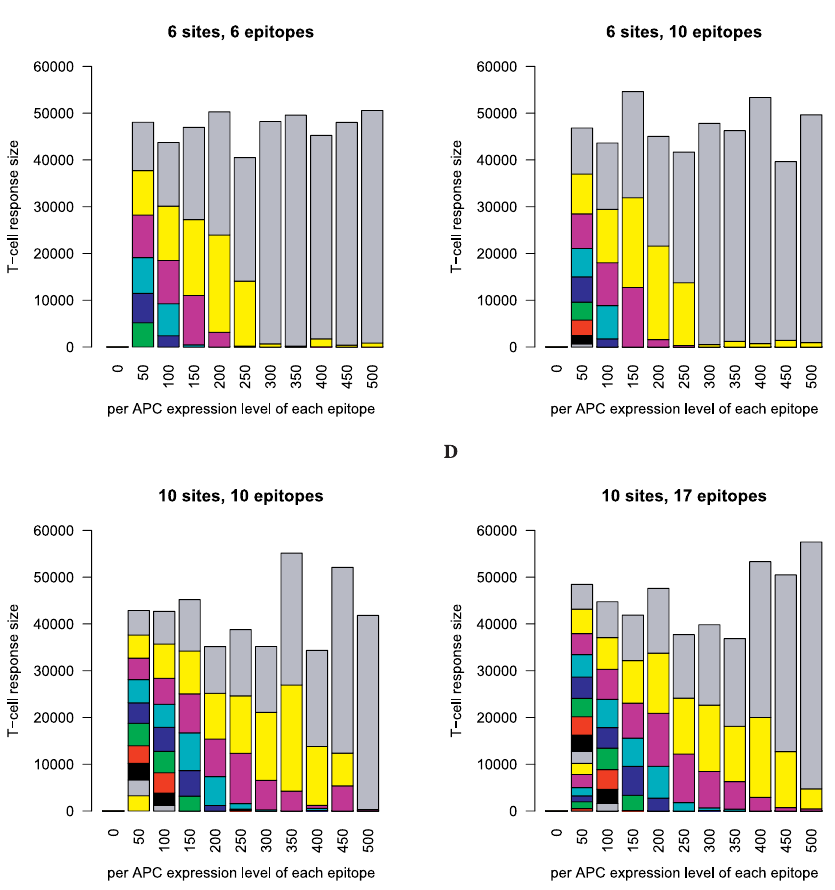
Figure 5. T Cell Diversity Decreases with Increasing per-APC Epitope Expression Level APCs with six T cell binding sites were simulated with six or ten presented epitopes (A and B, respectively), and APCs with ten T cell binding sites with 10 and 17 epitopes (C and D, respectively). Per bar, the different epitope-specific T cell populations are stacked and represented in different colours. For increasing epitope expression levels, T cell diversity drops from its maximum, which is when epitopes are presented at the amount necessary to activate a T cell (i.e., 50 copies of epitope), down to one for high epitope expression levels. Diversity reaches one when each epitope is expressed at sufficient levels to activate a T cell of the corresponding epitope specificity at each site of the APC, which is at epitope expression levels of 300 and 500 for APCs with six and ten T cell binding sites, respectively. T cell affinities of epitopes presented on APCs with six sites were as follows: for six epitopes, [0.05, 0.06, 0.07, 0.08, 0.09, 0.1], and for ten epitopes [0.03, 0.035, 0.04, 0.045, 0.05, 0.06, 0.07, 0.08, 0.09, 0.1]. On APCs with 10 sites and 10 epitopes, affinities ranged from 0.0375 to 0.06, and on APCs with 10 sites and 17 epitopes, affinities ranged from 0.02 to 0.06. Subsequently ranked T cell specificities always differed by 0.0025 in terms of their affinities. All other parameter settings are listed in Table 1. DOI: